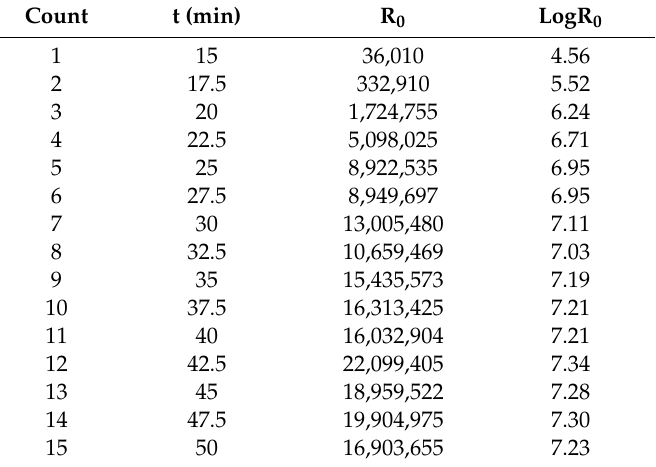
Figure 1. Experimental setup of the torrefaction process: ( a ) Nuve Muffle Furnace (Internal dimensions: 210W × 300D × 110Hmm) equipped with electric heating and a nitrogen generator that uses molecular sieves and ( b ) barley straw in a ceramic crucible placed in the cold furnace. Table 1. Ranking, time, severity factor and logarithm of severity factor for barley straw torrefaction design of